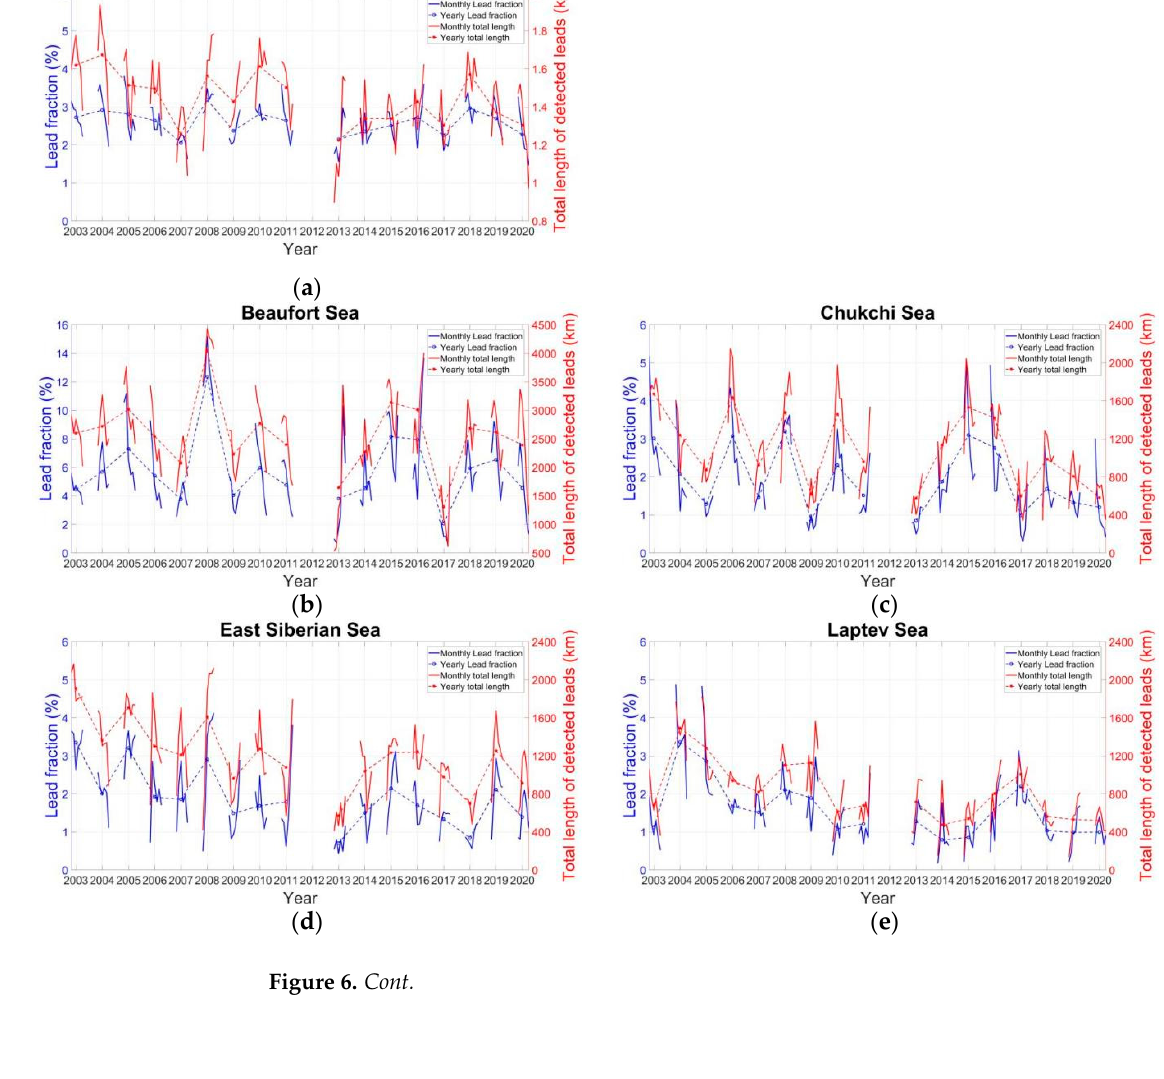
Figure 5. Division of the study areas in the Arctic north of 65°N.